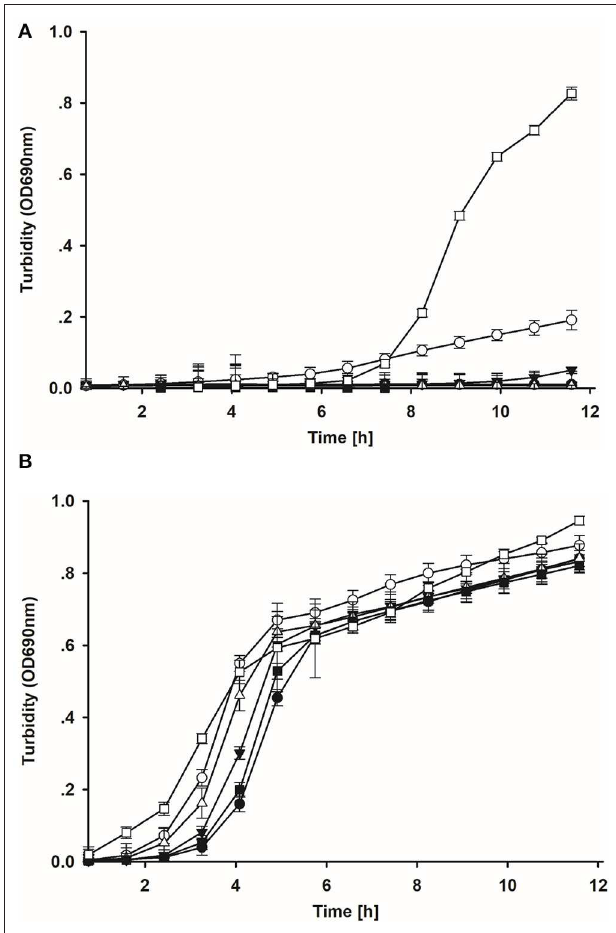
FIGURE 3 | (A) Growth of the model E. coli strain after ex vivo co-incubation with candidate lactic acid bacteria isolates for 8h in crop contents. Filled circle = S1; open circle = S26; filled down triangle = S62; open downward triangle open diamond = S70; filled square = S73; open square = control. (B) Growth of the model E. coli strain after ex vivo co-incubation with candidate lactic acid bacteria isolates for 8h in jejunum contents. Filled circle = S1; open circle = S26; filled down triangle = S62; open downward triangle open diamond = S70; filled square = S73; open square = control.